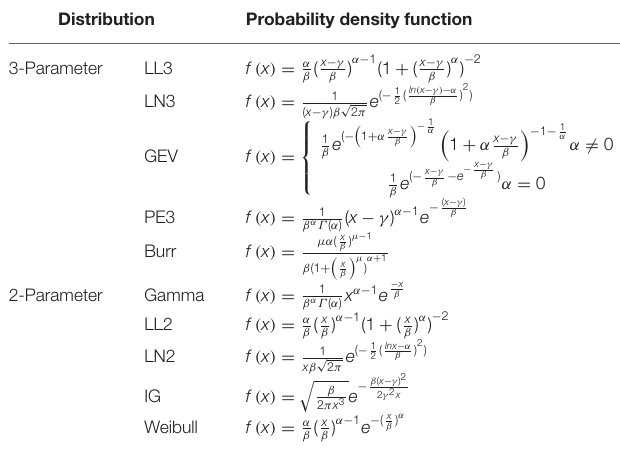
TABLE 1 | Drought classification according to SPI values. TABLE 2 | Probability density function of each distribution.